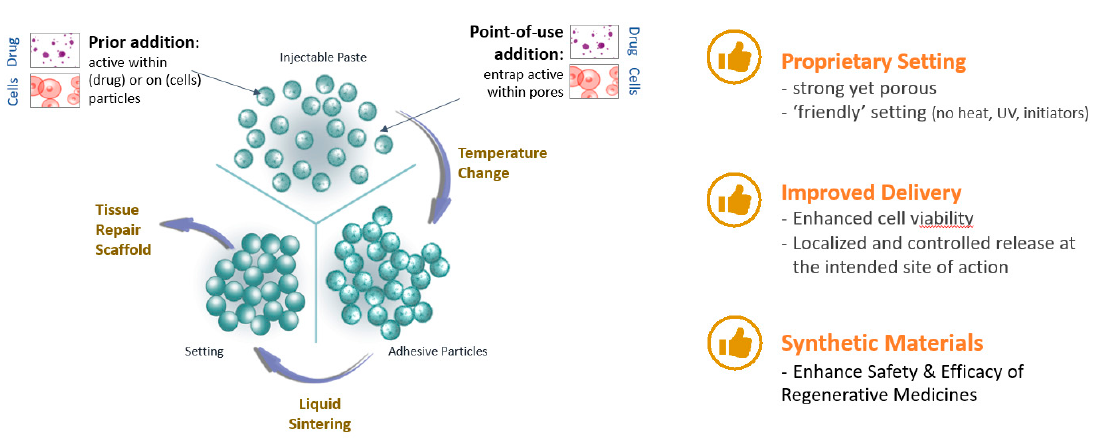
Figure 7. Mode of action of TAOS TM (Targeted Orchestrated Signaling) matrix.